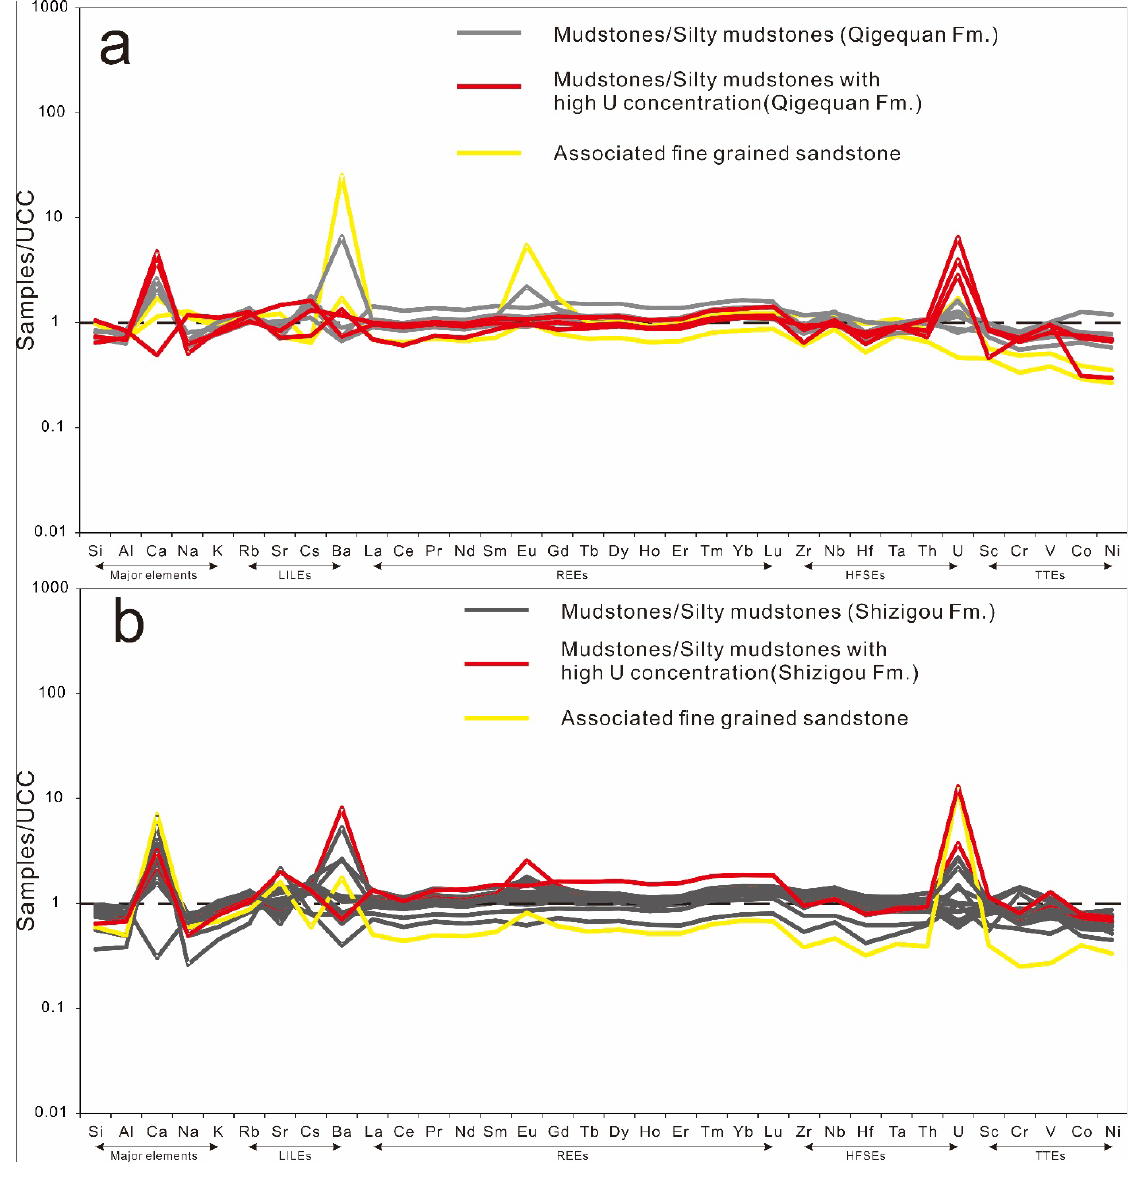
Figure 6. Upper continental crust-normalized variation diagrams for rocks samples from Qigequan Formation ( a ) and Shizigou Formation ( b ) in this study. Upper continental crust values are from [78].